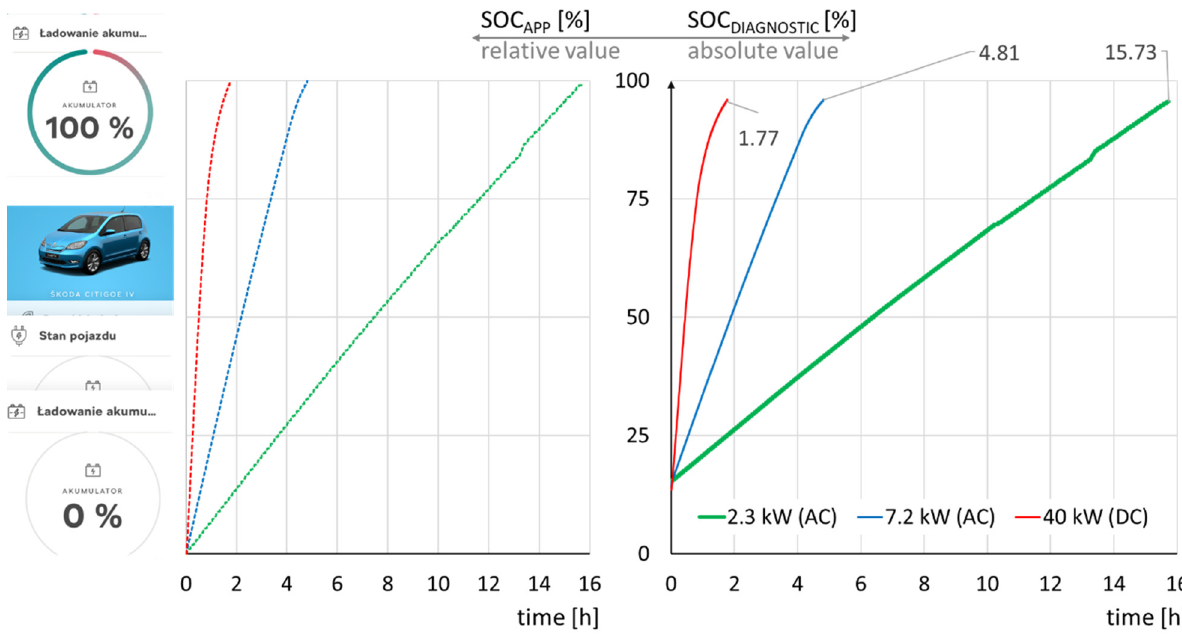
Figure 16. Charging time for the ŠKODA CITIGO e iV depending on the selected method (comparison of the application’s readings with the actual values of the battery charge status—application screenshots shown on the left).